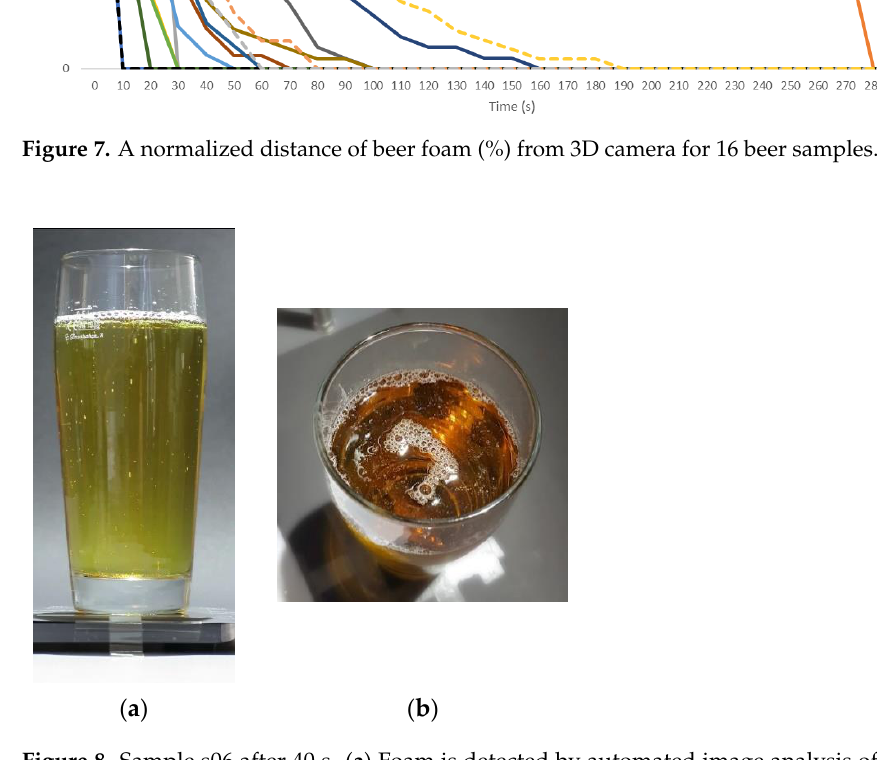
Figure 7. A normalized distance of beer foam (%) from 3D camera for 16 beer samples.